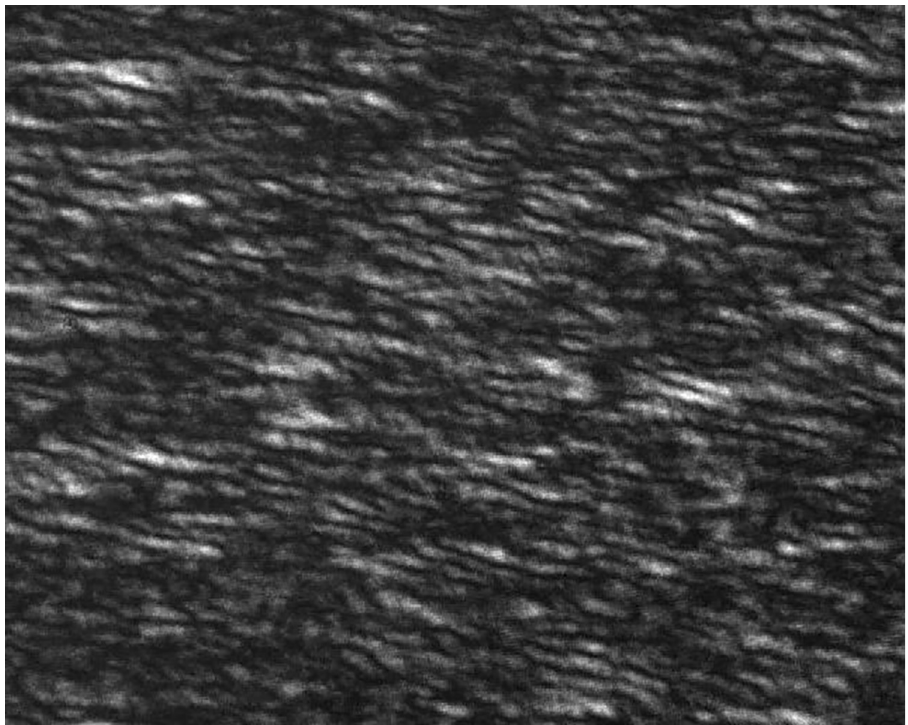
Fig 1. A typical laser biospeckle pattern generated from plant